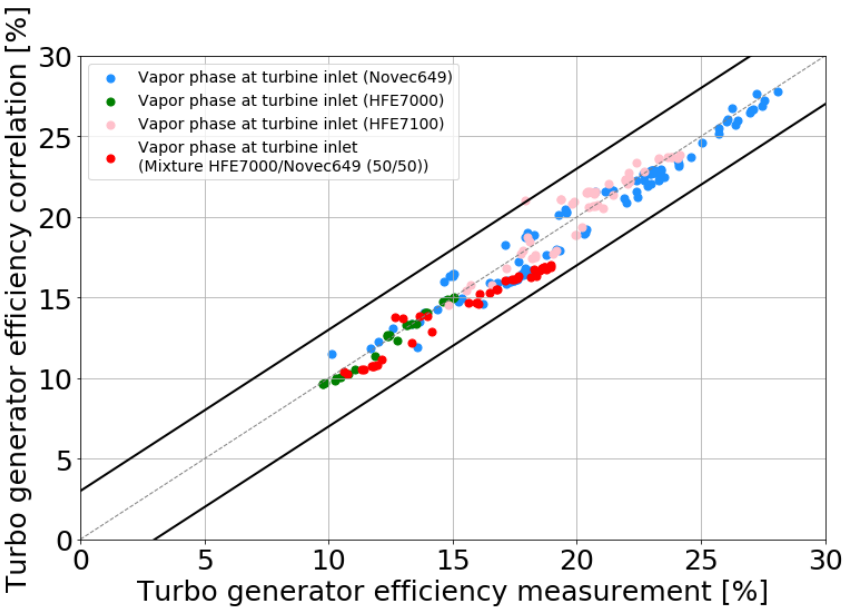
Figure 15. turbo-generator efficiency correlation based on turbo-generator efficiency measurement. Figure 15. Turbo-generator efficiency correlation based on turbo-generator efficiency